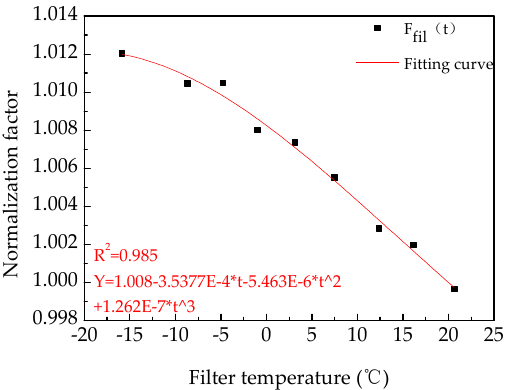
Figure 13. Experimental results of F fil (t). The transmittance change exhibited by the filter was approximately 1.20% as t decreased from 20 °C to − 15 °C.